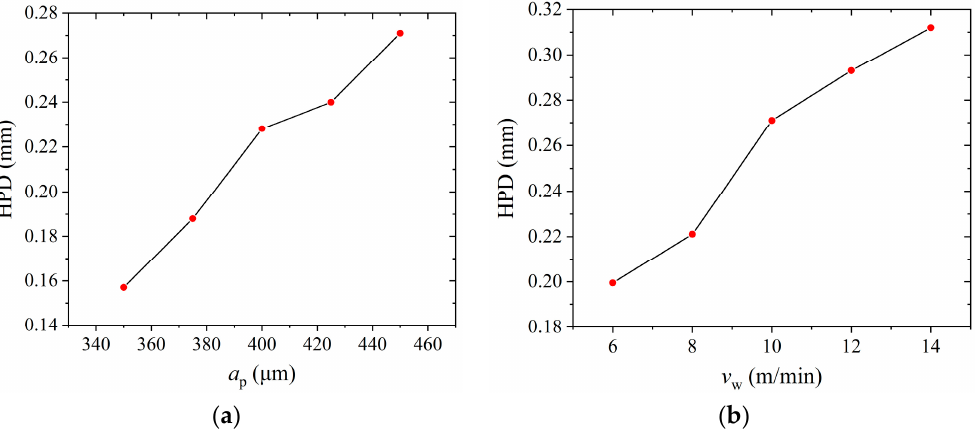
Figure 9. HPD prediction with di ff erent grinding parameters. ( a ) v w = 10 m / min, v s = 26.4 m / s; ( b ) a p = 450 µ m, v s = 26.4 m / s.